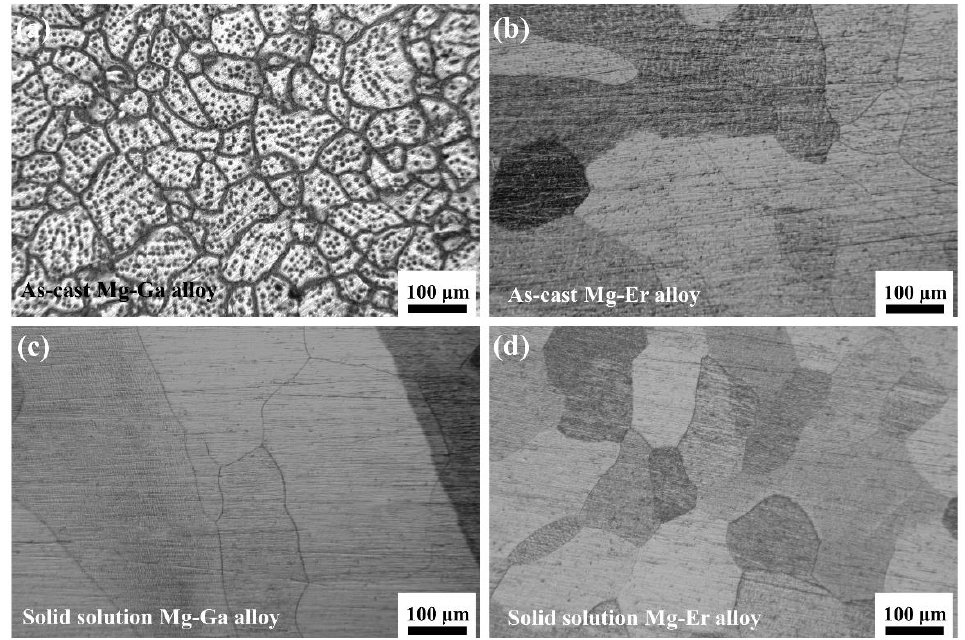
Figure 1. OM images of ( a ) as-cast Mg-Ga alloy; ( b ) as-cast Mg-Er alloy; ( c ) solid solution Mg-Ga alloy; ( d ) solid solution Mg-Er alloy.